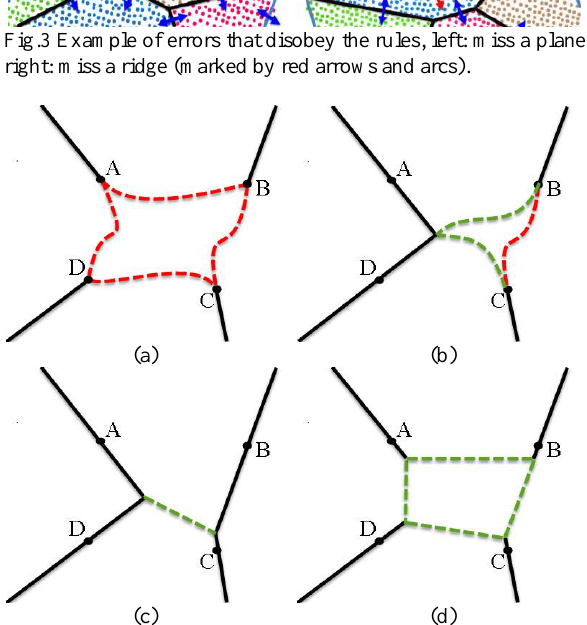
Fig.4. Examples of correct manners, (a) origin region, (b) expansion, (c) add ridges/step wall, (d) add new plane.